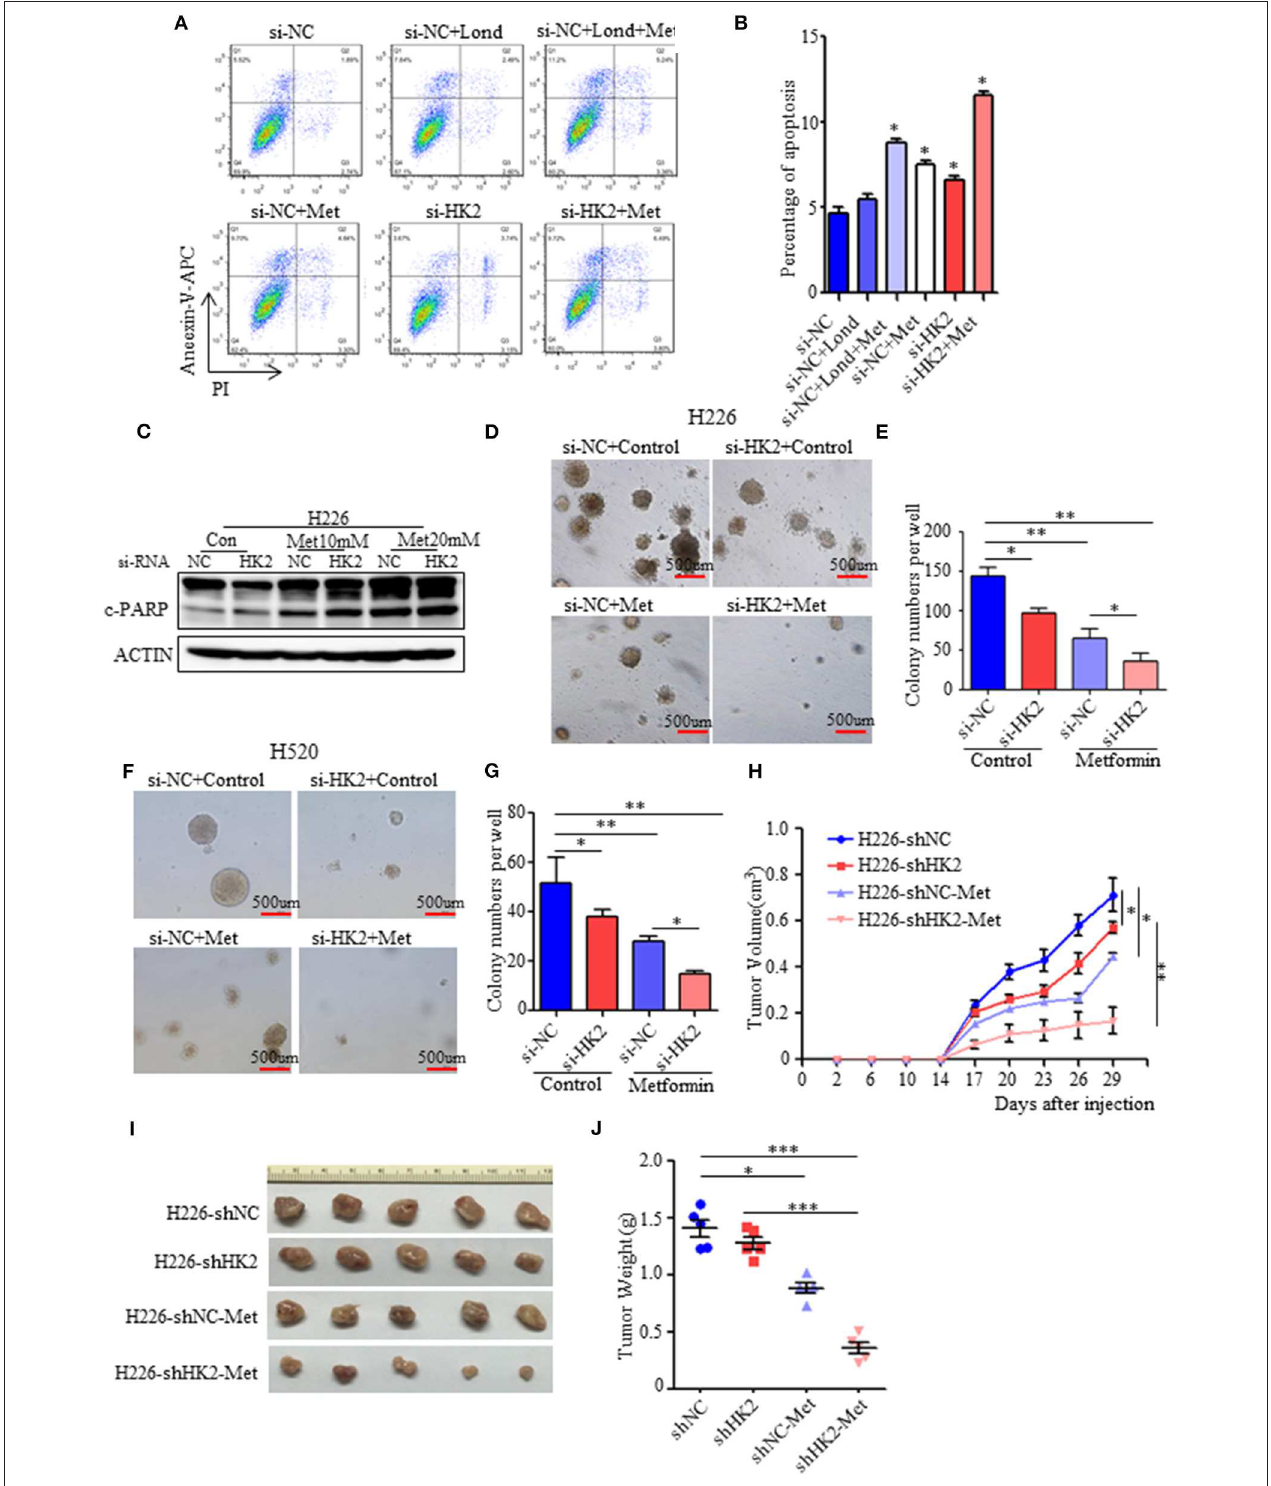
FIGURE 6 | Effect of HK2 knockdown and metformin on cell death and tumor growth. (A,B) The effect of HK2silencing or treatment with lonidamine in combination with metformin (10mM) on death of H226 cells. (C) Immunoblot showing the expression of cleaved PARP in H226 siNC- and H226 siHK2-transfected cells with or without treatment of different doses of metformin. (D) Colony formation assay showing the anchorage-independent growth in H226 si-NC-transfected cells compared